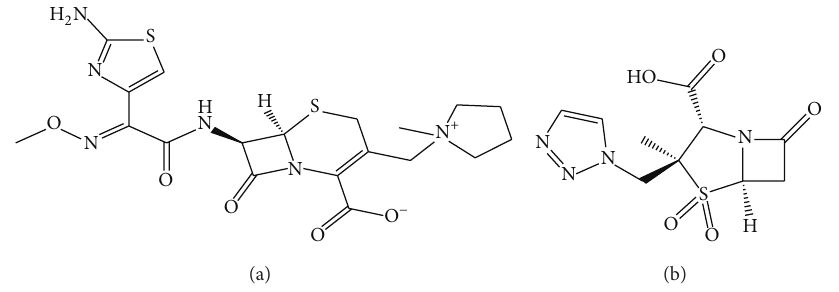
Figure 1: Chemical structure of (a) cefepime (b) tazobactam.